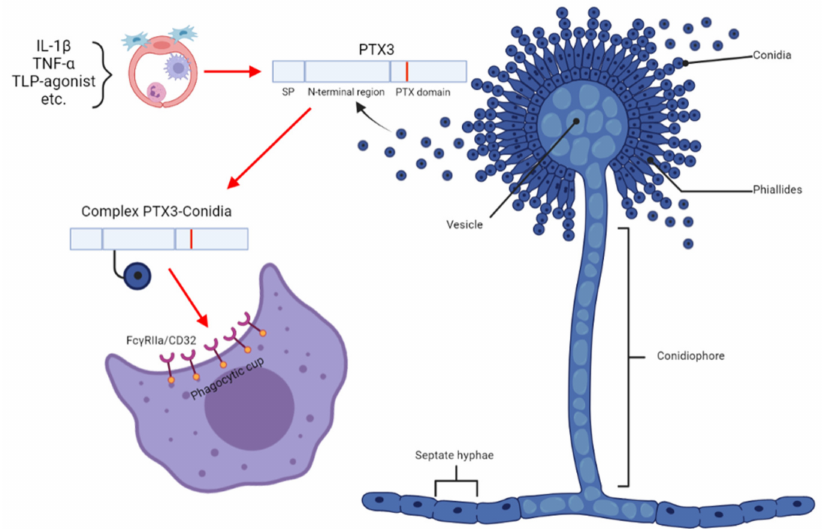
Figure 1. The role of Pentraxin 3 in the Aspergillus conidial model. IL-1 β , interleukin 1- β ; TNF- α , tumor necrosis factor α ; Fc γ RIIa/CD32 proteins (also known as CD32 in the Cluster of Differentiation) are activating-type Fc receptors, the Fc γ RII family are active as receptors for immunoglobulins, and Fc γ RIIA acts as a receptor for pentraxins. The image was generated with Biorender software (https://biorender.com/ (accessed on 1 January